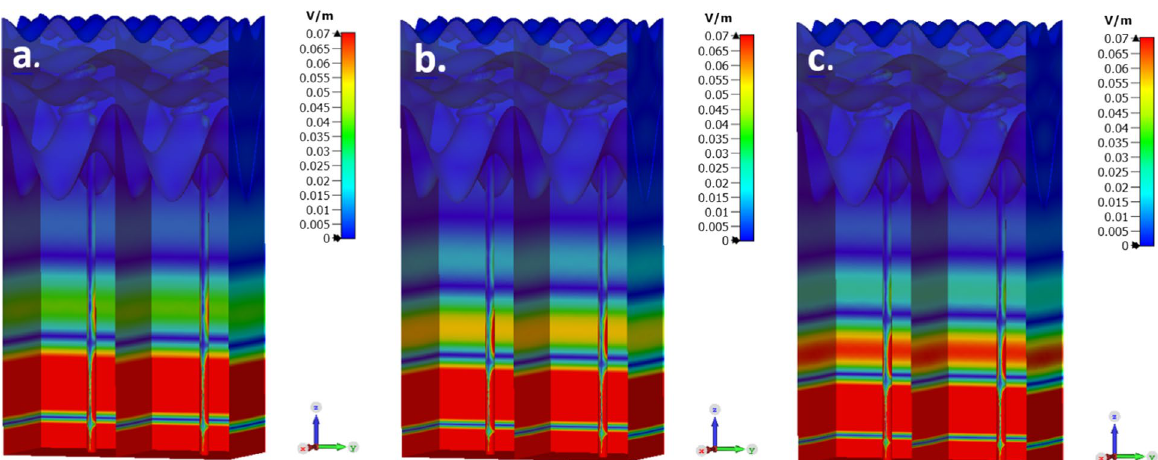
Figure 7. Electrical field distribution simulated for three of the nine different frequencies, which were simulated in the range of 500 GHz up to 700 GHz, with a constant frequency interval of 25 GHz. ( a ) 500 GHz, ( b ) 600 GHz and ( c ) 700 GHz. The duct conductivity is 1,000 S/m and power average of 5 nW. The phase for all frequencies was fixed to 145°. This figure was generated using CST STUDIO SUITE v2021 30 , https:// www. 3ds. com/ produ cts- servi ces/ simul ia/ produ cts/ cst- studio- suite/ 30